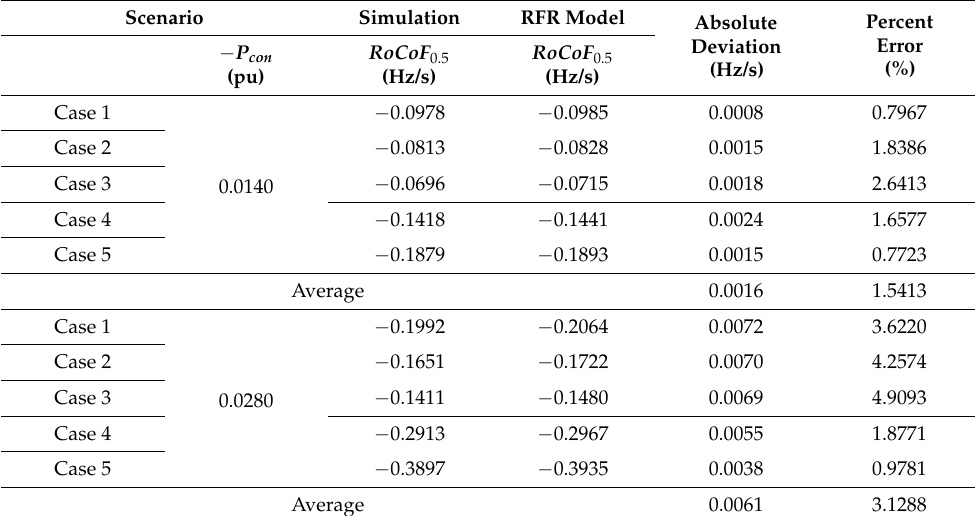
Table 4. Comparison of average RoCoF in each scenario based on 1